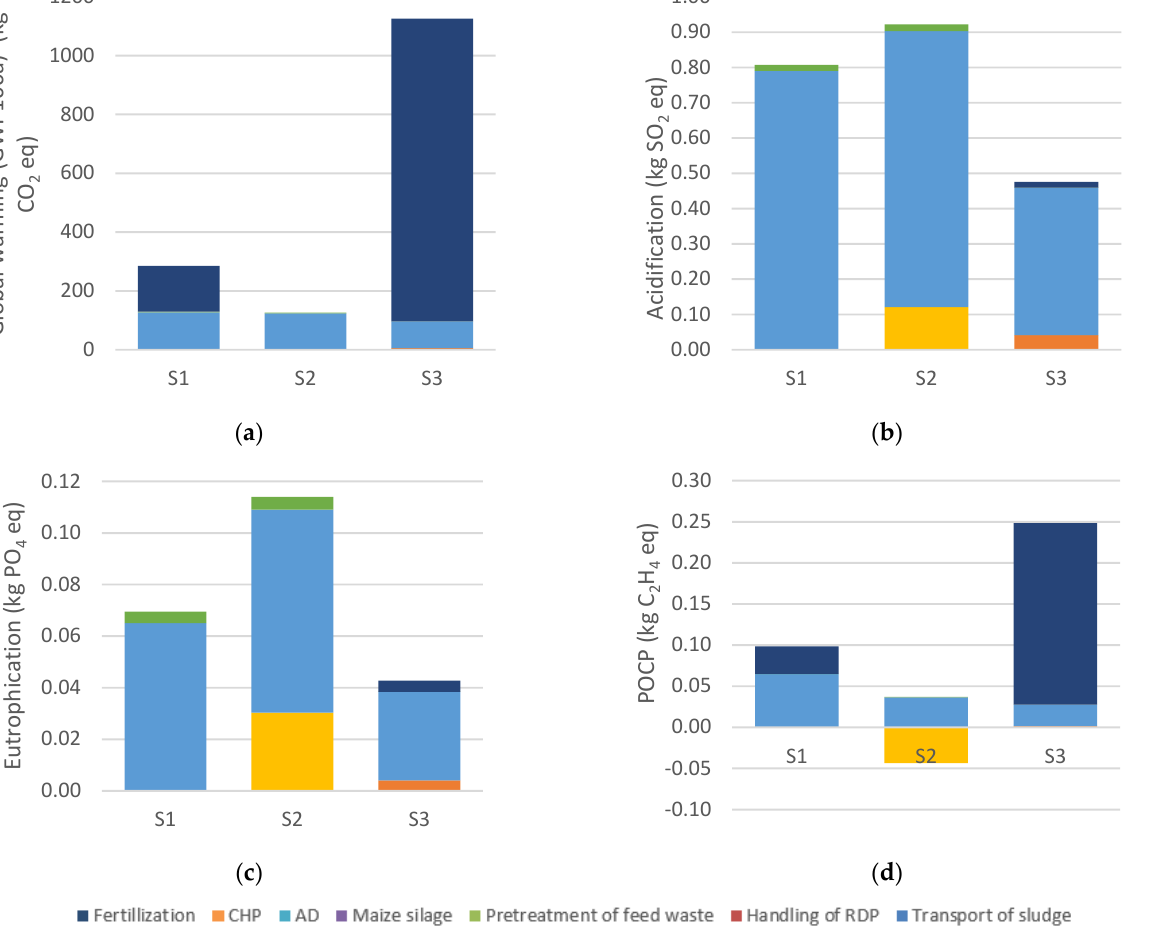
Figure 2. Environmental impact for all scenarios: ( a ) global warming potential, GWP100a; ( b ) acidification potential, AP; ( c ) eutrophication potential, EP; ( d ) photochemical potential, POCP.